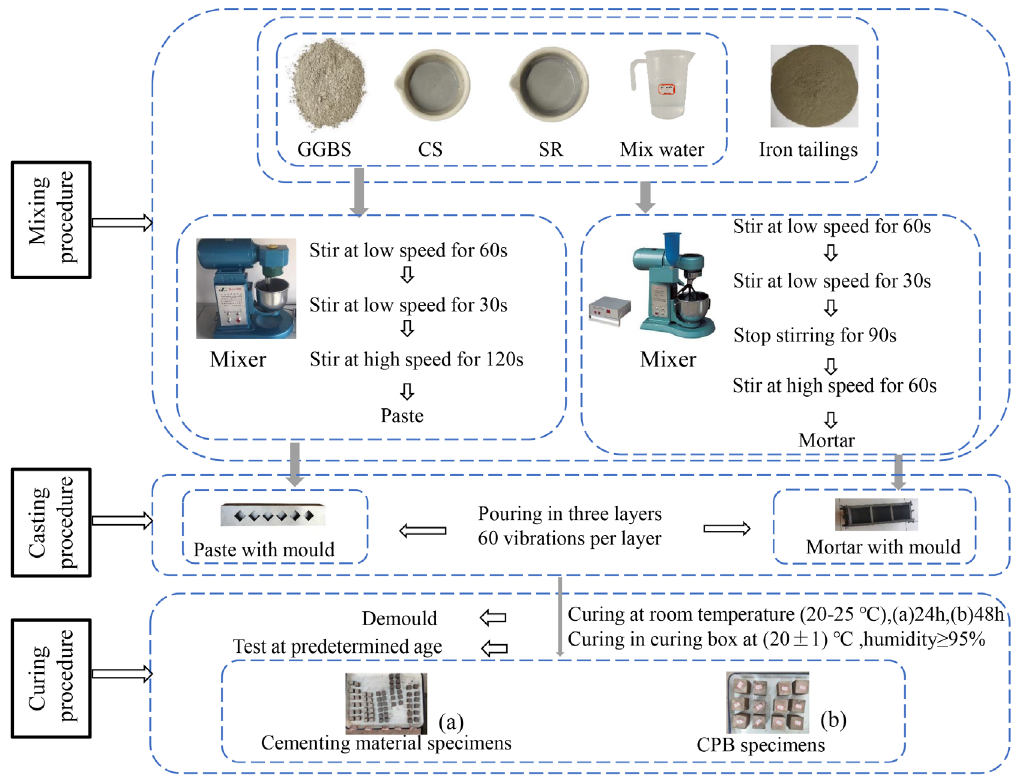
Figure 2. Mixing, casting, and curing procedures of